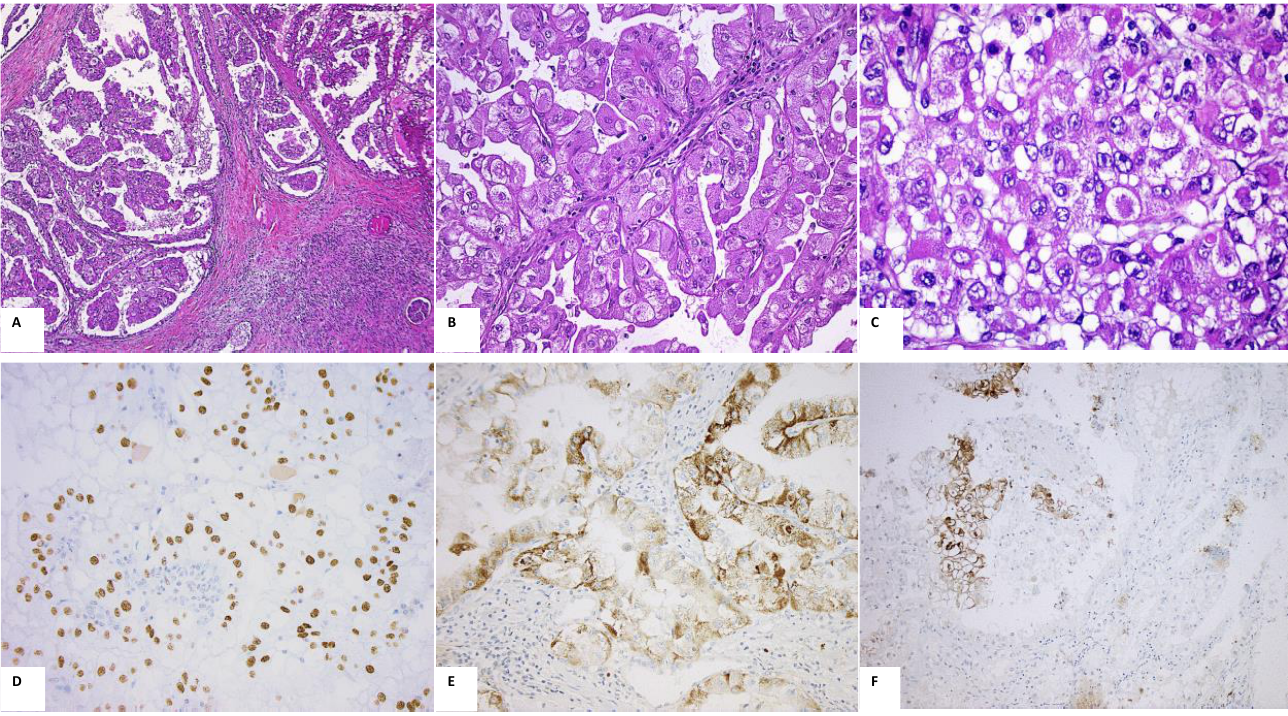
Figure 1. Morphological and immunohistochemical features of TFE3-tRCC. Captions: ( A – C ): Morphology and features. ( A / B ) Papillary architecture; C: eosinophilic cells with prominent nucleoli (HES staining, magnification ( A ) ×50, ( B ) ×200, ( C ) ×200); ( D – F ): immunohistochemical features. ( D ): TFE3 positivity of the majority of nuclei; ( E ): p504 cytoplasmic positivity for some cells; ( F ): CAIX positivity in hypoxic territory (TFE3/p504/CAIX IHC, respectively, magnification ×200); tRCC: trans- location renal cell carcinoma; HES: hematoxylin – eosin – safran.